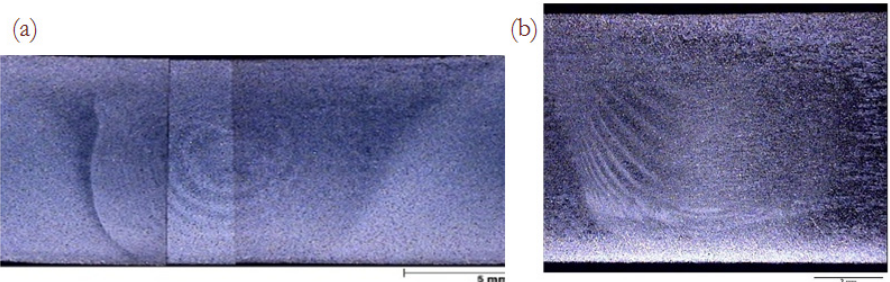
Figura 3: Micrografie ottiche delle sezioni trasversali dei giunti FSW sui compositi (a) W6A20A e (b)